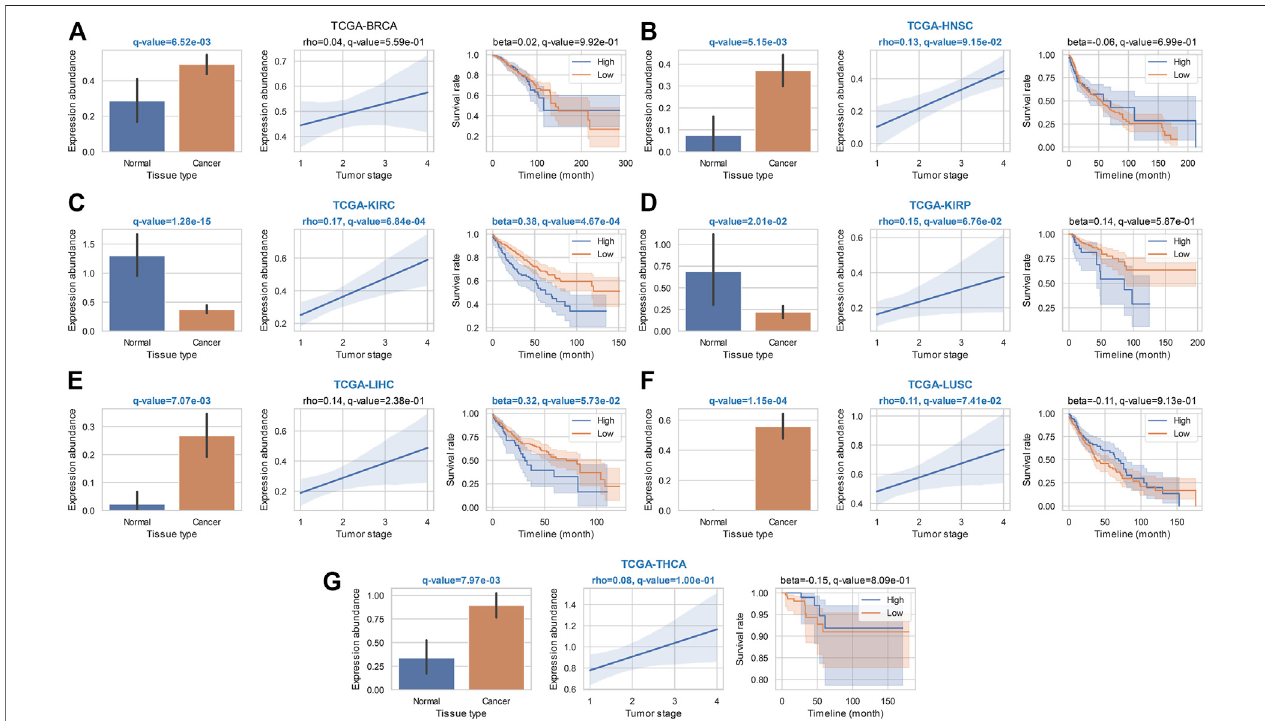
FIGURE4| Statisticalresultsofawidelyidenti fi edca-tRF (tRF-28-RS9NS334L2DB) inca-tRFscreening.Barplot(with errorbars),correlogram,Kaplan-Meier plot fortRF-28-RS9NS334L2DBinthestatisticaltestsofcde-tRF,tsca-tRF,andpsca-tRFscreeningarerespectivelydepictedandq-valuesaswellaskeyindicators(i.e.,rho of Spearman ’ s correlation and beta of Cox regression) are shown above the plots. The signi fi cant q-values ( < 0.1) are highlighted with blue and bold font. Meanwhile, if tRF-28-RS9NS334L2DBislistedasca-tRFinonecancertype(twooutofthreesets),thecancertypenameisalsohighlighted.Theresultsin (A) BRCA; (B) HNSC; (C) KIRC; (D) KIRP; (E) LIHC; (F) LUSC, and (G) THCA are shown